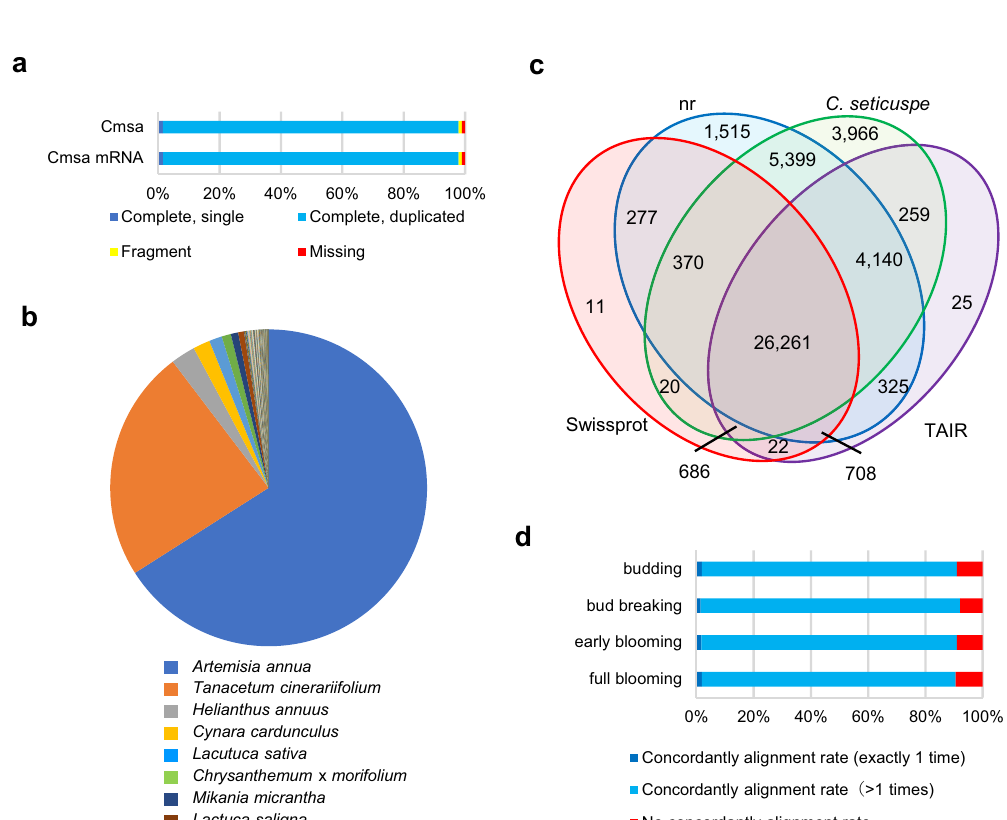
Figure 4. Features of the Chrysanthemum morifolium ‘Sei Arabella’ transcript dataset (Cmsa). ( a ) Result of the BUSCO assessment of the Cmsa and Cmsa mRNA dataset on Embryophyta data. ( b ) Similarities of representative mRNA transcript isoform sequences with those of other species were analyzed from the results of a blastp search against the NCBI nr database. ( c ) Venn diagram of homology search results of the amino acid sequences predicted from the representative mRNA sequences of the Cmsa dataset. The blue circle indicates nr (NCBI nr database). The green circle indicates C. seticuspe (CSE_r1.1.pep database). The red circle indicates Swiss-Prot (Uniprot Knowledgebase (UniProtKB/Swiss-Prot). The purple circle indicates TAIR ( Arabidopsis thaliana protein sequences (Arabidopsis_thaliana.TAIR10.pep.all.fa)). ( d ) Alignment rate of short-read sequence from C. morifolium cultivar ‘Jinba’ pefal toward the Cmsa data using the Bowtie2